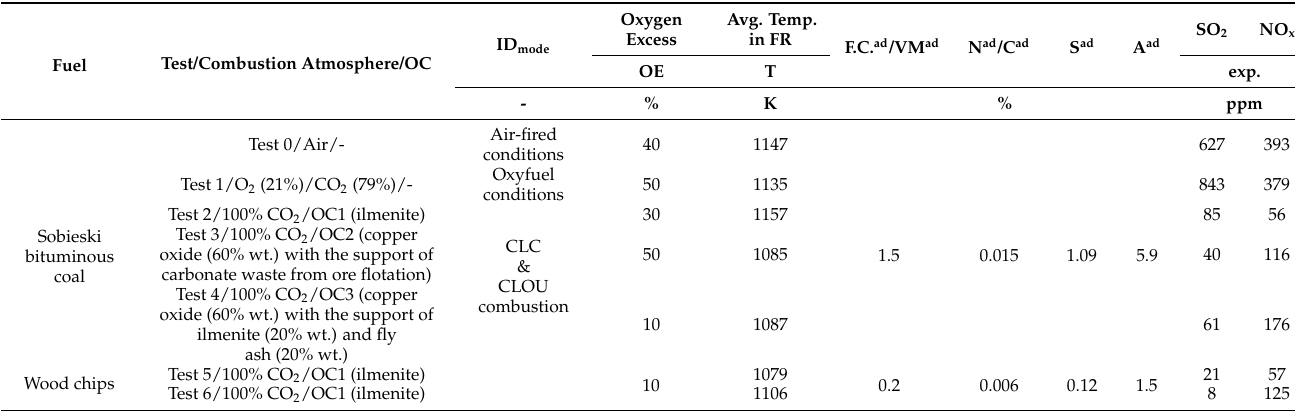
Table 2. The operating parameters (ad—air-dried